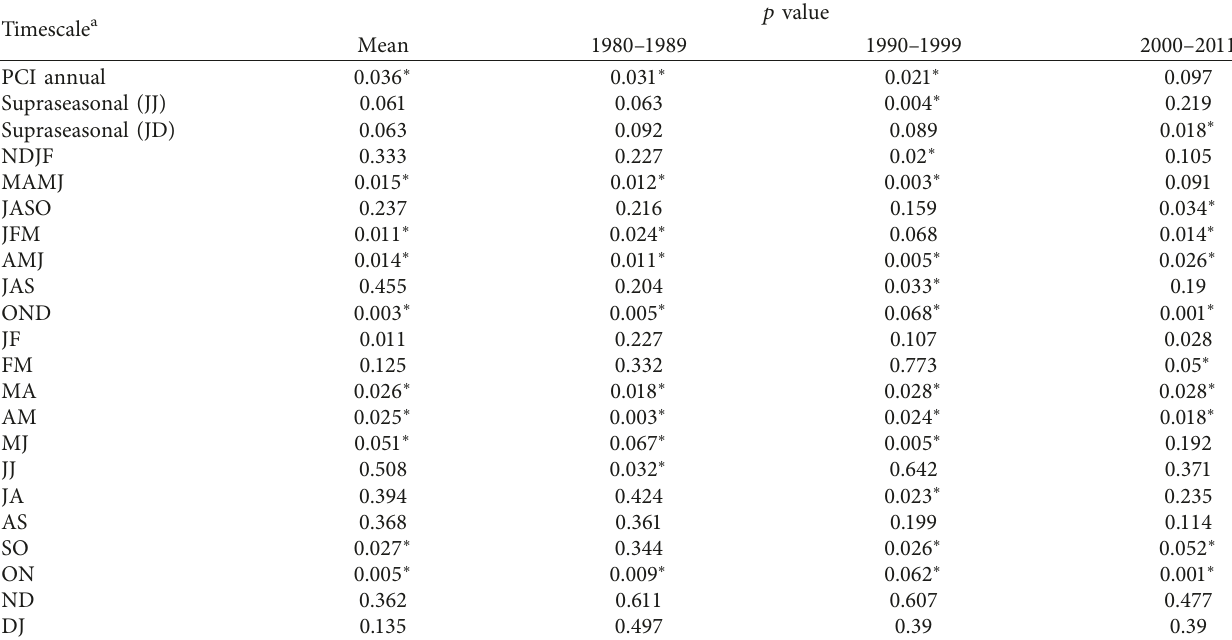
Table 1: The regional differences in the mean PCI using the Kruskal–Wallis test during 1980–1989, 1990–1999, and 2000–2011 in Bangladesh.